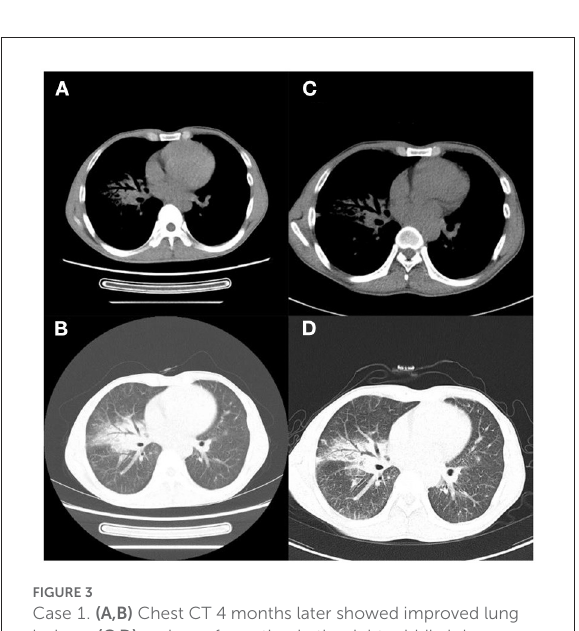
FIGURE3 Case 1. (A,B) Chest CT 4 months later showed improved lung lesions; (C,D) and scar formation in the right middle lobe bronchus 8 months later.